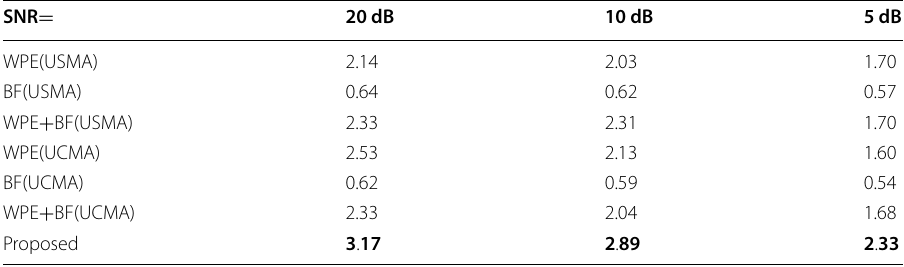
Boldface indicates the best score for each condition